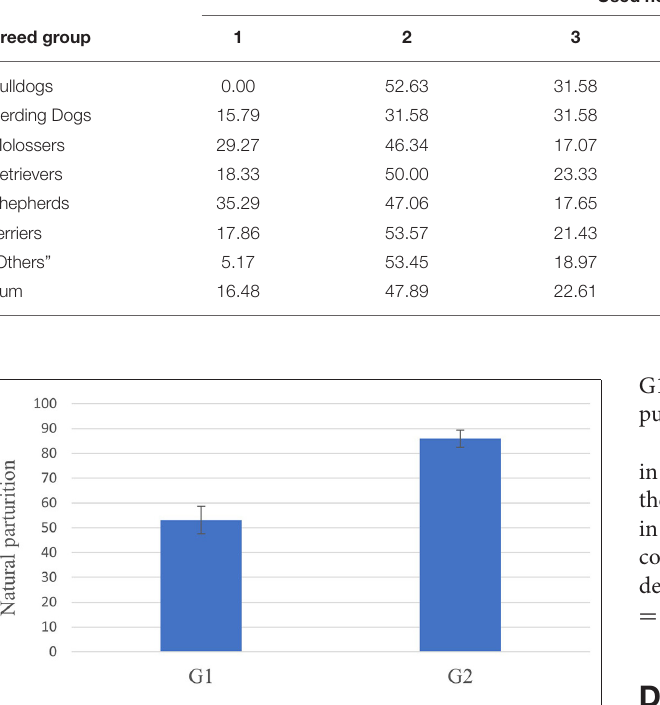
FIGURE 1 | Estimated frequencies [LSMeans ± standard error (SE)] for natural parturition depending on G1 and G2. Animals in G2 had experienced